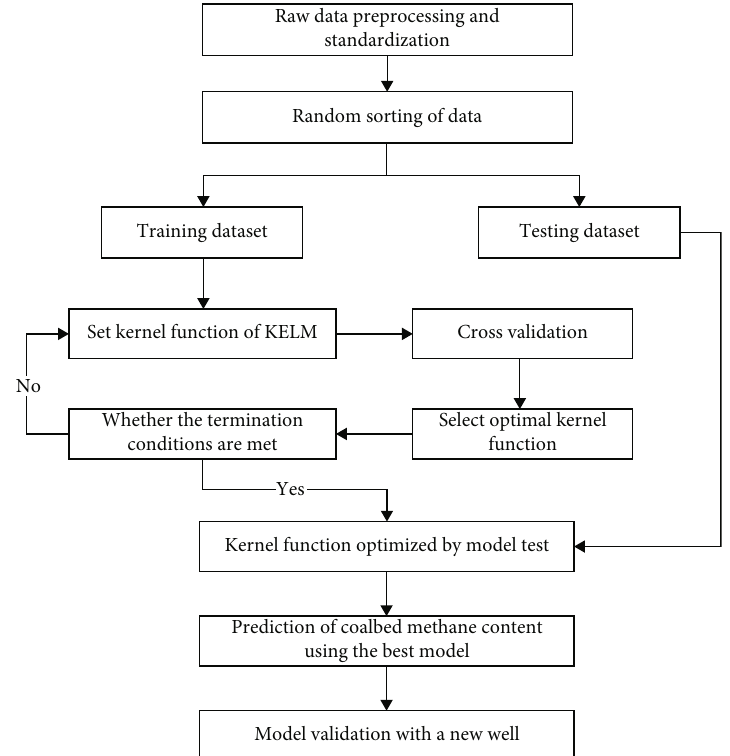
Figure 9: Work fl ow of the CBM content prediction based on the KELM